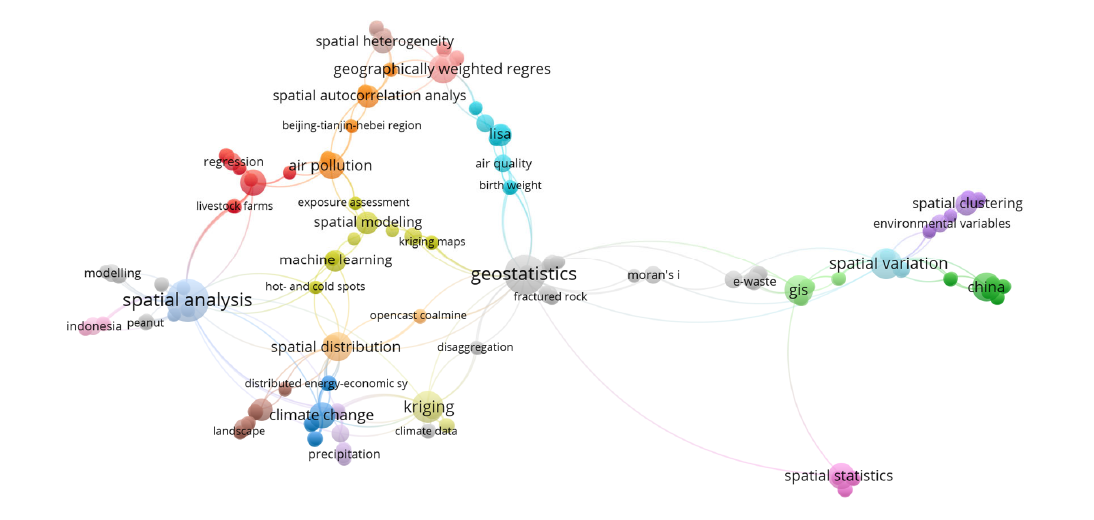
Fig. 3. Co-occurrence-word network for Dataset